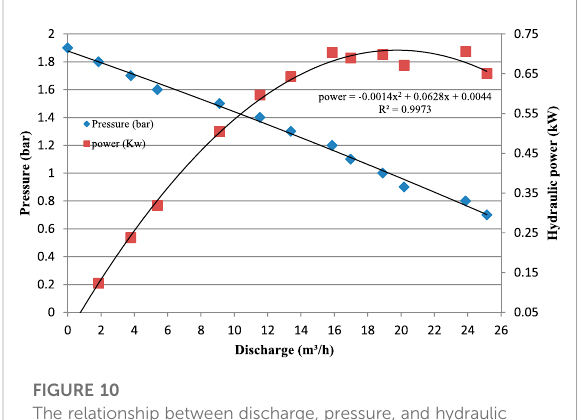
FIGURE 11 The relationship between discharge, pressure, and hydraulic power of a pump operating with the VM mixer at an engine speed of 3,500